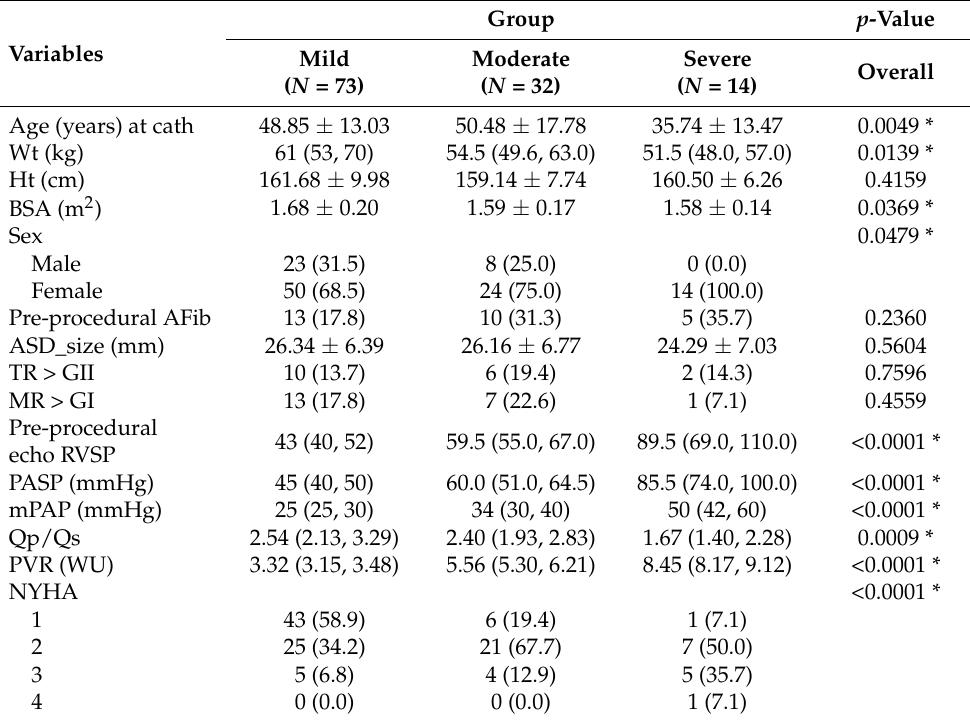
Table 1. Baseline characteristics of patients with ASD according to the degree of PAH.